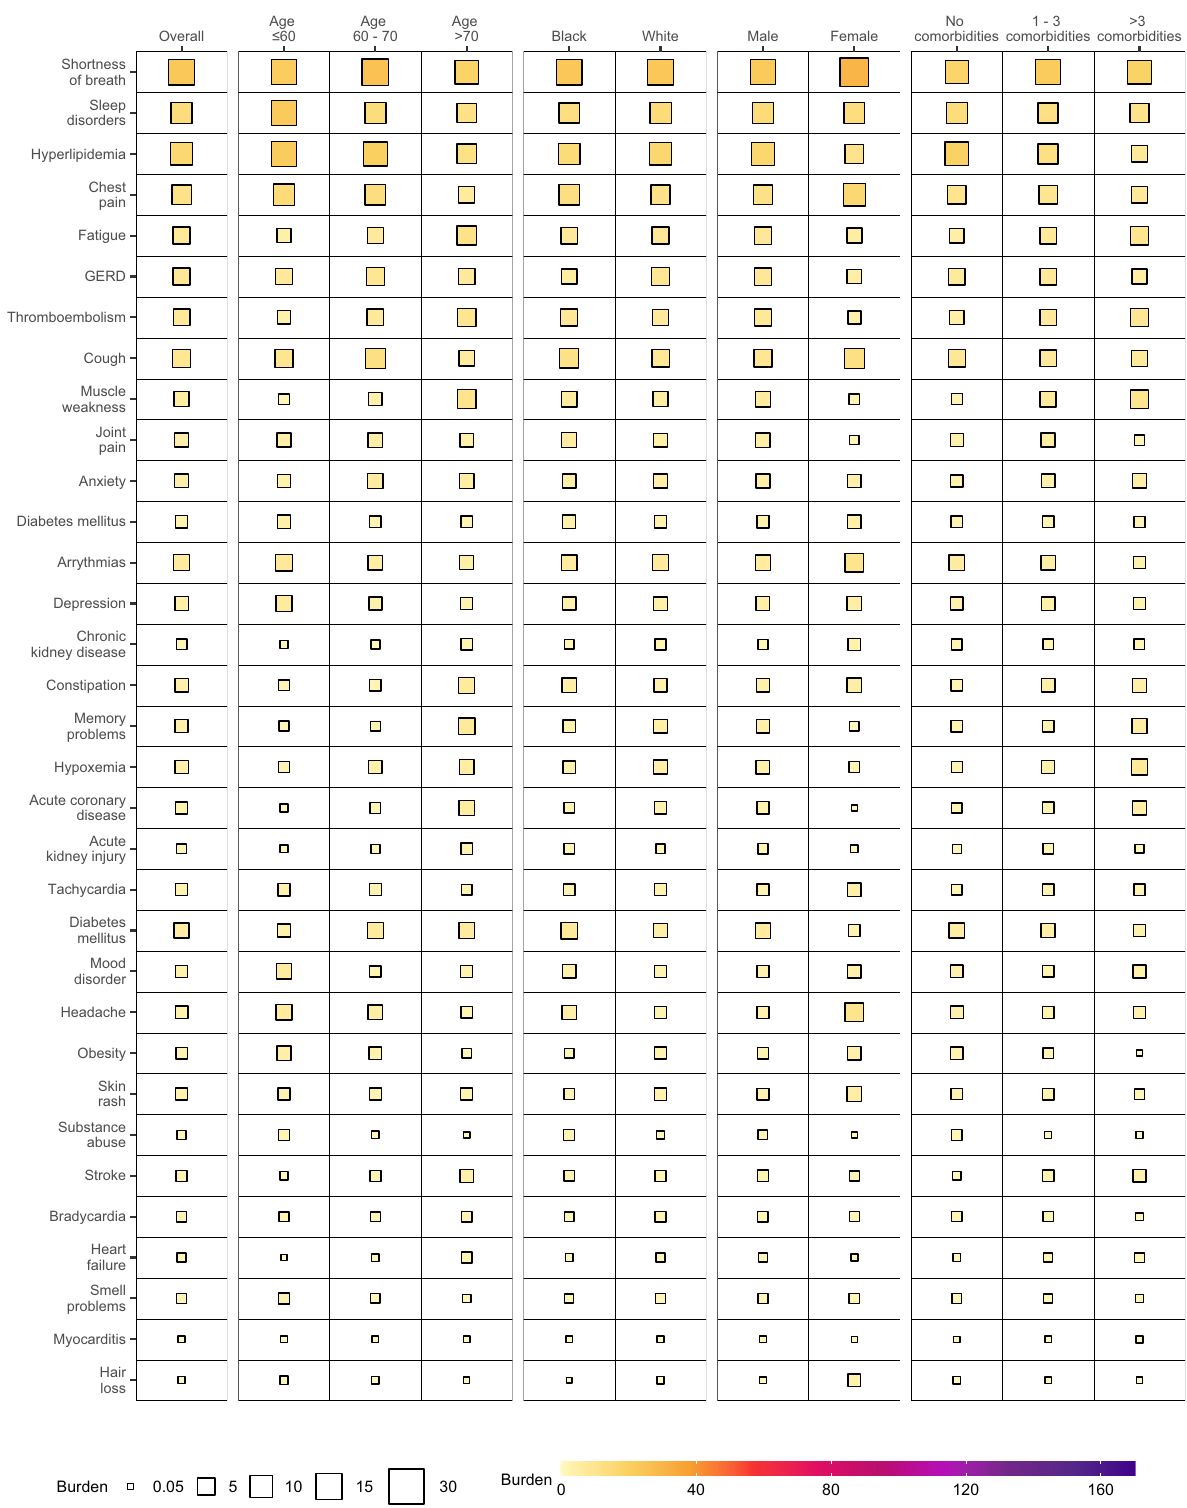
weaknessCoughThromboembolismGERDFatigueChest painMuscle mellitusAnxietyJoint diseaseDepressionArrythmiasDiabetes problemsConstipationChronic kidney diseaseHypoxemiaMemory injuryAcute coronary mellitusTachycardiaAcute disorderDiabetes rashObesityHeadacheMood abuseSkin failureBradycardiaStrokeSubstance problemsHeart lossMyocarditisSmell Hair Fig. 5 Burden of post-acute sequelae of COVID-19 in the overall cohort and by age, race, sex, and health status in non-hospitalized COVID-19. Estimates of burdens per 1000 COVID-19 patients at 6 months are presented. The size of the square represents the burden within each care setting. The intensity of color from light yellow to deep purple represents the range of burdens across care settings. Models adjusted for age, race, sex, receipt of long- term care, Area Deprivation Index, number of outpatient encounters, number of hospital admissions, number of outpatient prescriptions, number of outpatient serum creatinine measurements, chronic lung disease, cancer, cardiovascular disease, cerebrovascular disease, dementia, diabetes mellitus, hypertension, hyperlipidemia, depression, anxiety, chronic kidney disease, hepatitis C and peripheral artery disease, overweight, obesity, smoking status, Charlson Comorbidity Index, US geographic region, total number of beds, number of COVID-19 tests administered, COVID-19 positivity rate, and average hospital bed occupancy during the week of participant enrollment when